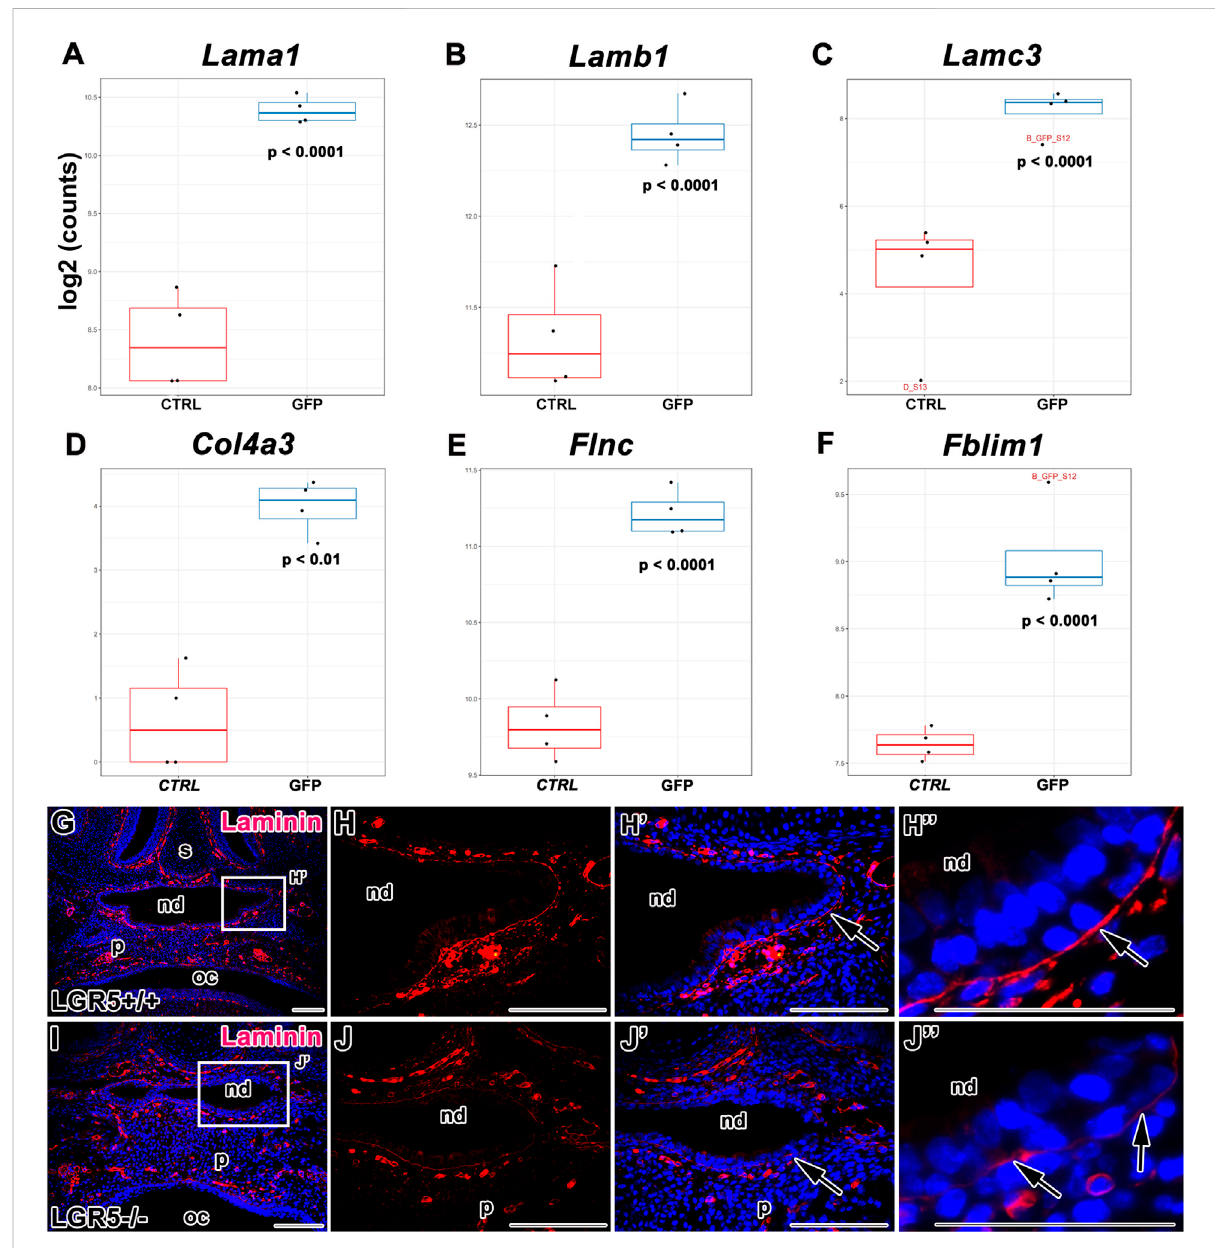
FIGURE 14 Geneexpressionofmoleculesassociatedwithbasalmembrane. (A – F) Differencesingeneexpressionof Lama1,Lamb1,Lamc3,Flnc and Fblim1 in LGR5/EGFP-positive and LGR5/EGFP-negative cells. Laminin expression in WT (G-H´´) and Lgr5 -de fi cient animals (I-J´´) detected by immunohistochemistry displays weaker signal of basal membrane marker in mutant animals nd, nasopharyngeal duct; oc, oral cavity; p, palate; s, septum. Scale bars = 100 μ m. The graphs values indicate average ±SD and p value when data were compared with the corresponding control